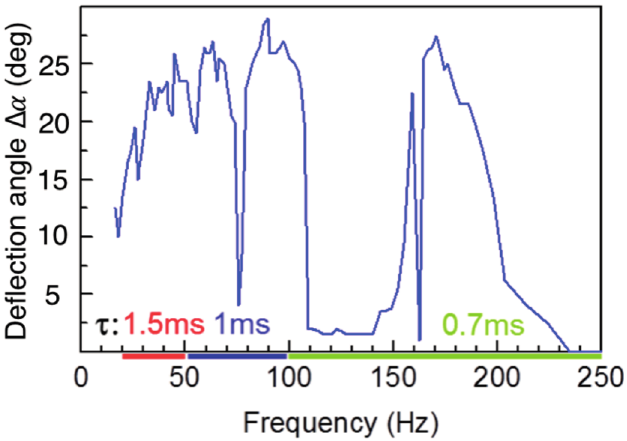
Figure 13. Deflection angle versus frequency of a polycrystalline Ni–Mn–Ga double beam cantilever with lateral size of 3 × 0.4 mm 2 . The duration of heating pulses τ is decreased for increasing frequency f from 1.5 ms ( f < 50 Hz) via 1 ms (50 < f < 100 Hz) to 0.7 ms ( f > 100 Hz) as